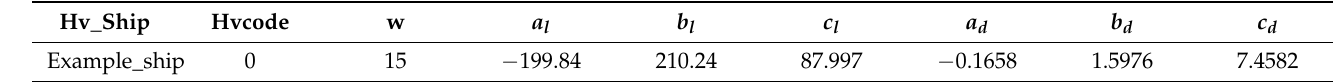
Table 3. Example of hv curve